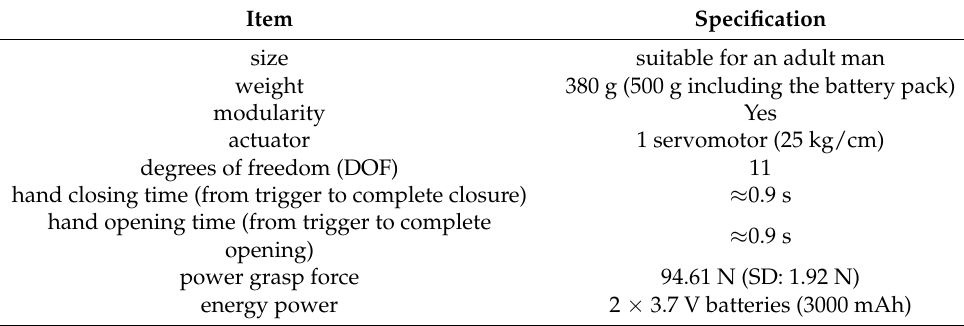
Table 1. Design specifications for the hand exoskeleton. Item Specification size suitable for an adult man